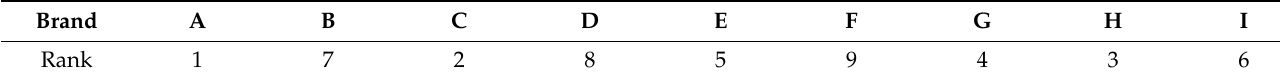
Table 10. The ranking of brand